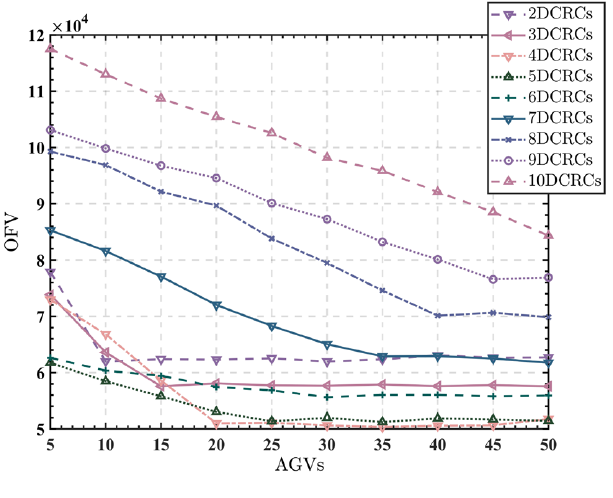
Figure 15. OFV at 2 QCs.